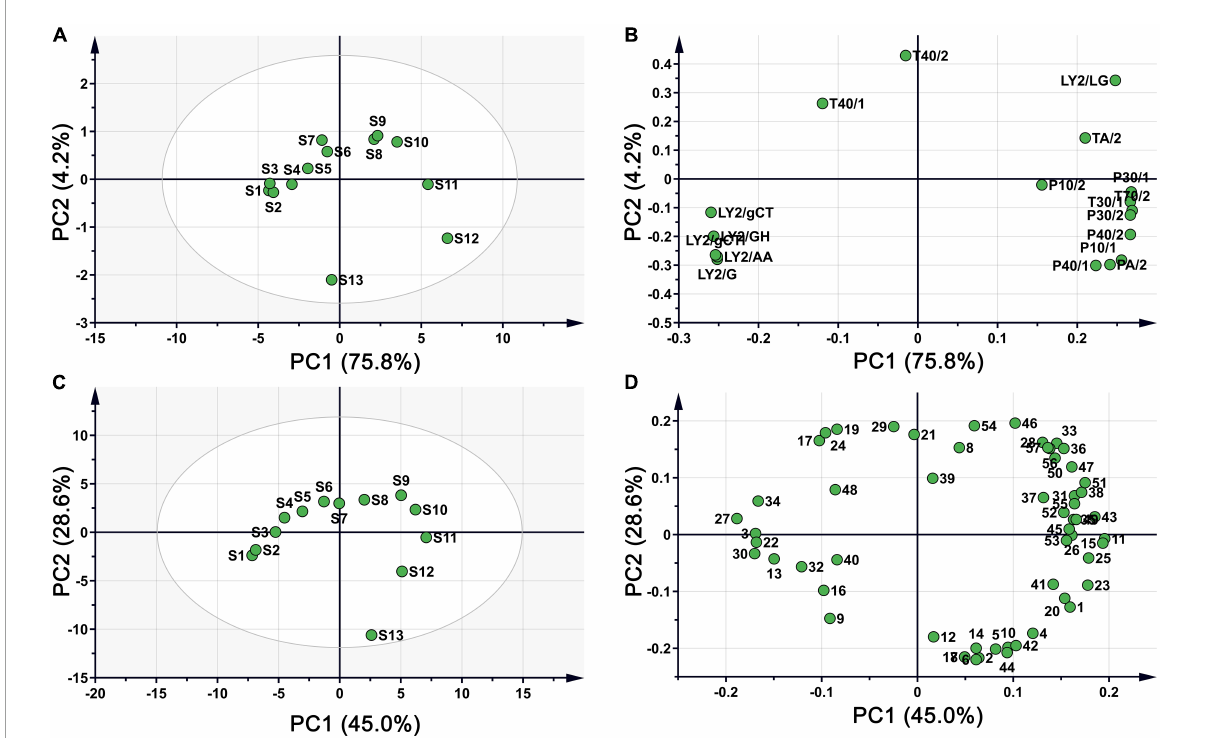
FIGURE3 PCA plot of CF samples during roasting process. (A) Score plot based on E-nose; (B) loading plot based on E-nose; (C) score plot based on HS-GC-MS; (D) loading plot based on